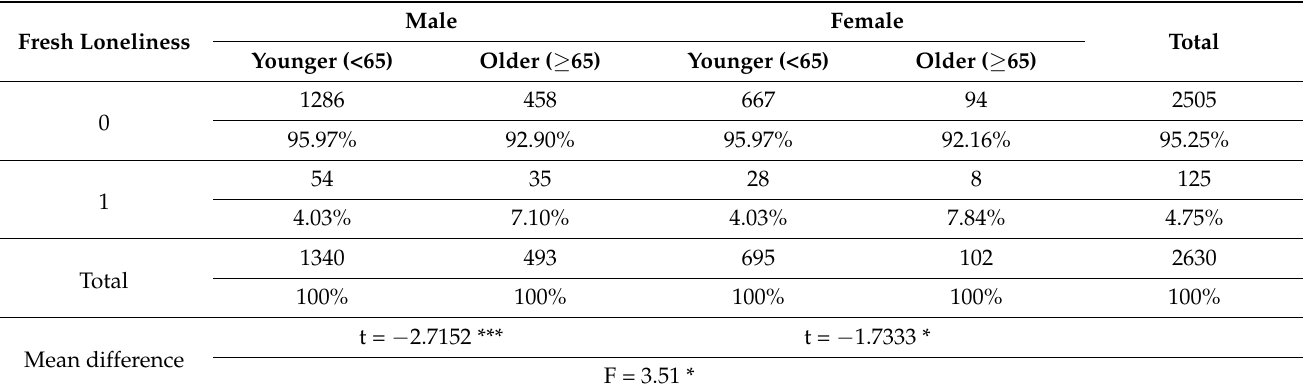
Table 5. Distribution of fresh loneliness by gender and age